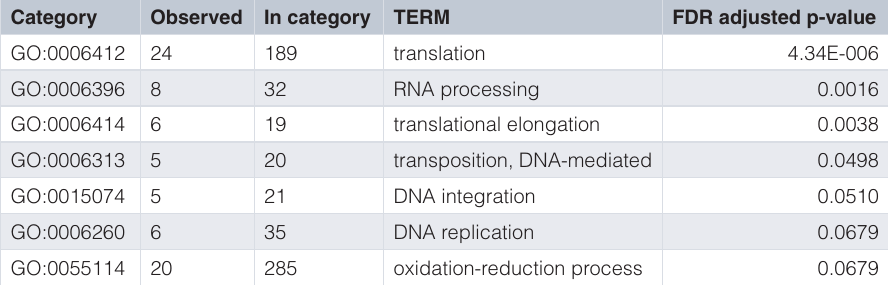
Supplemental Table S6. Gene Ontology analyses of derived SNPs in SB-charr.